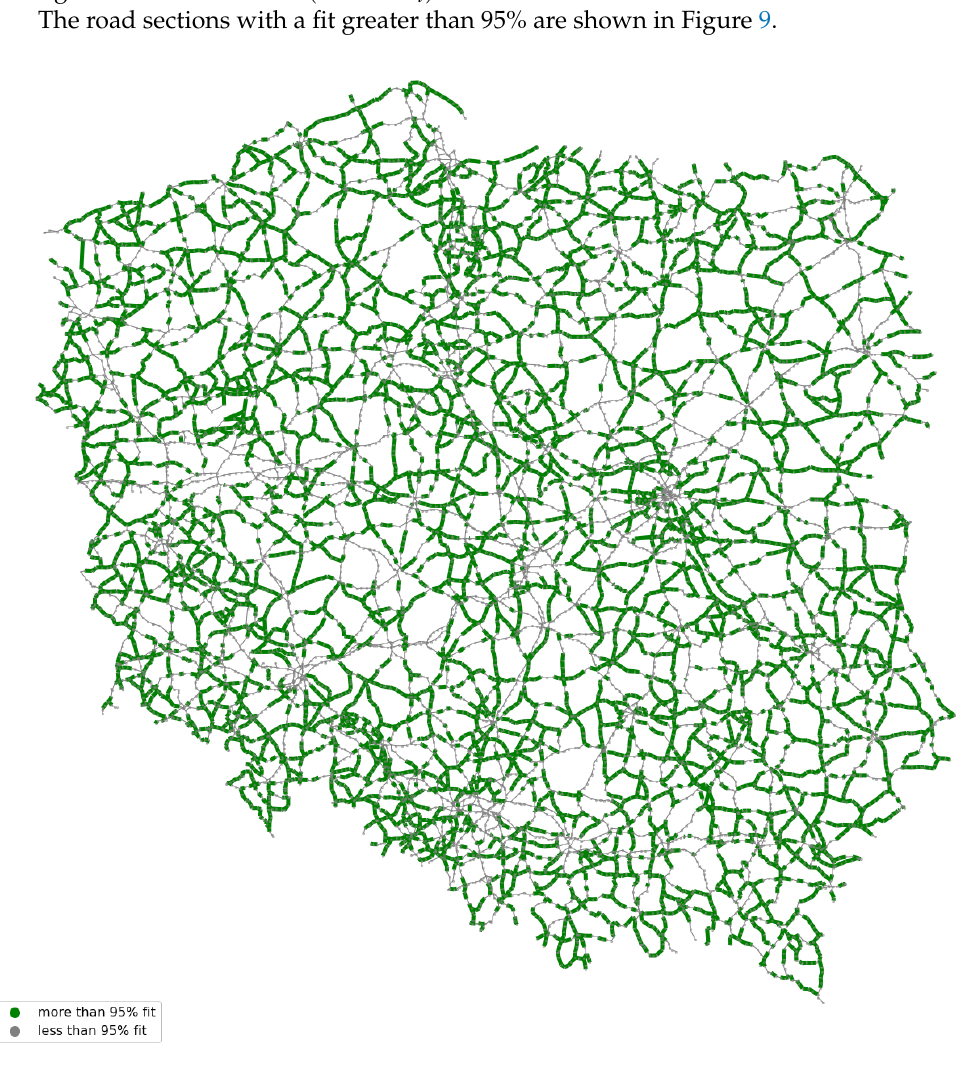
Figure 9. Sections of the road network with a degree of matching above 95%. The results of the absolute model error assessment show that the average error for all checked network sections was